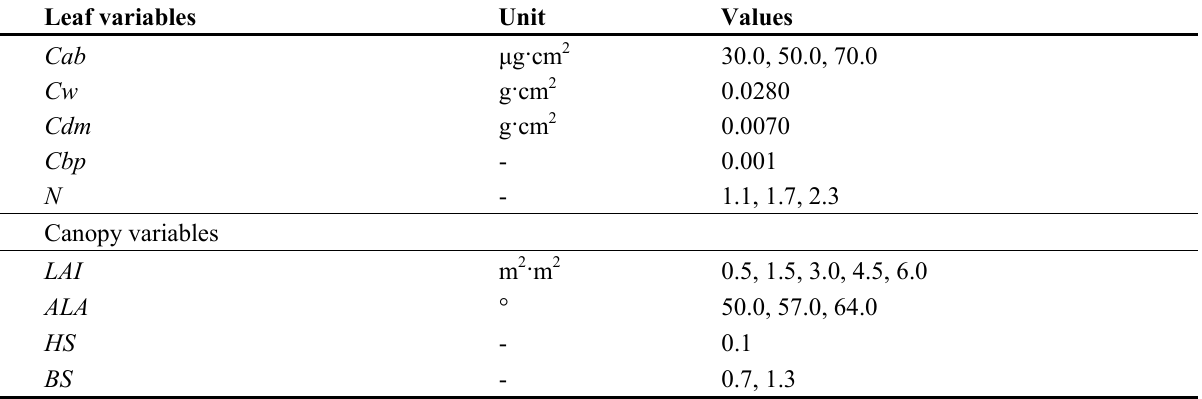
Table 2. Parameterization used for the synthetic data set.